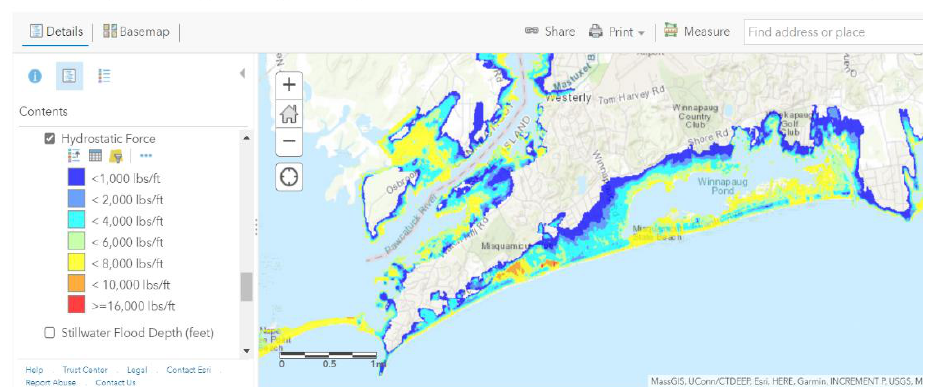
Figure 7. Hydrostatic load (lbs/ft), 100 yr storm, 0 ft sea level rise (SLR) ( upper panel) and 5 ft SLR ( lower panel).